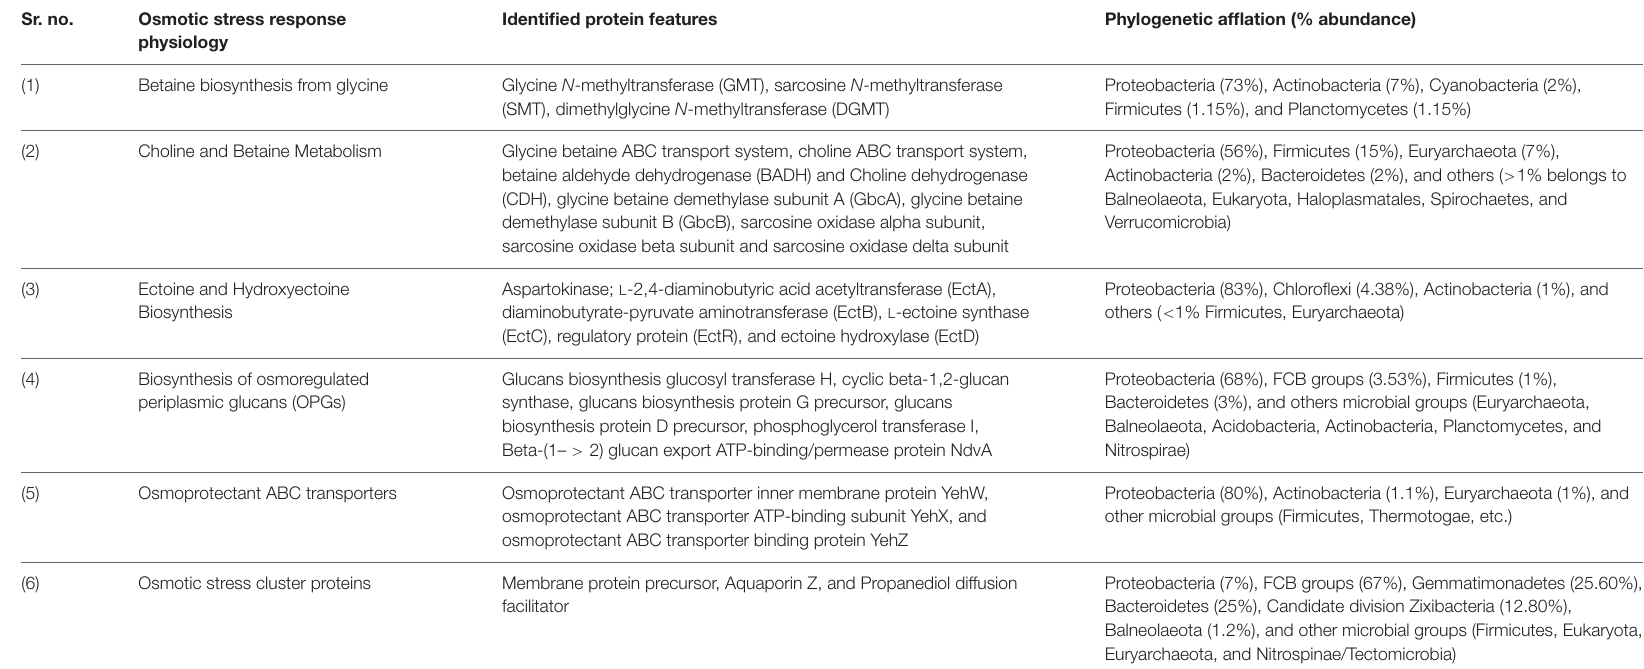
TABLE 1 | Metagenomic features associated with osmotic stress response physiology in Sambhar Salt Lake microbiome. Sr.